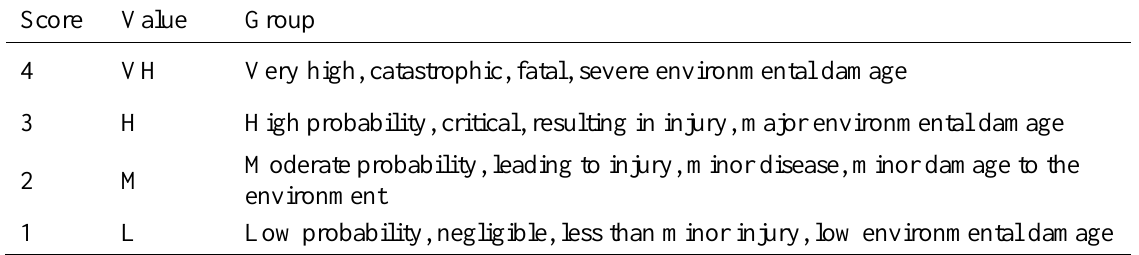
Table 4. Value of probability factors and severity in RAM-D method(Matalucci Rudolph, 2002)